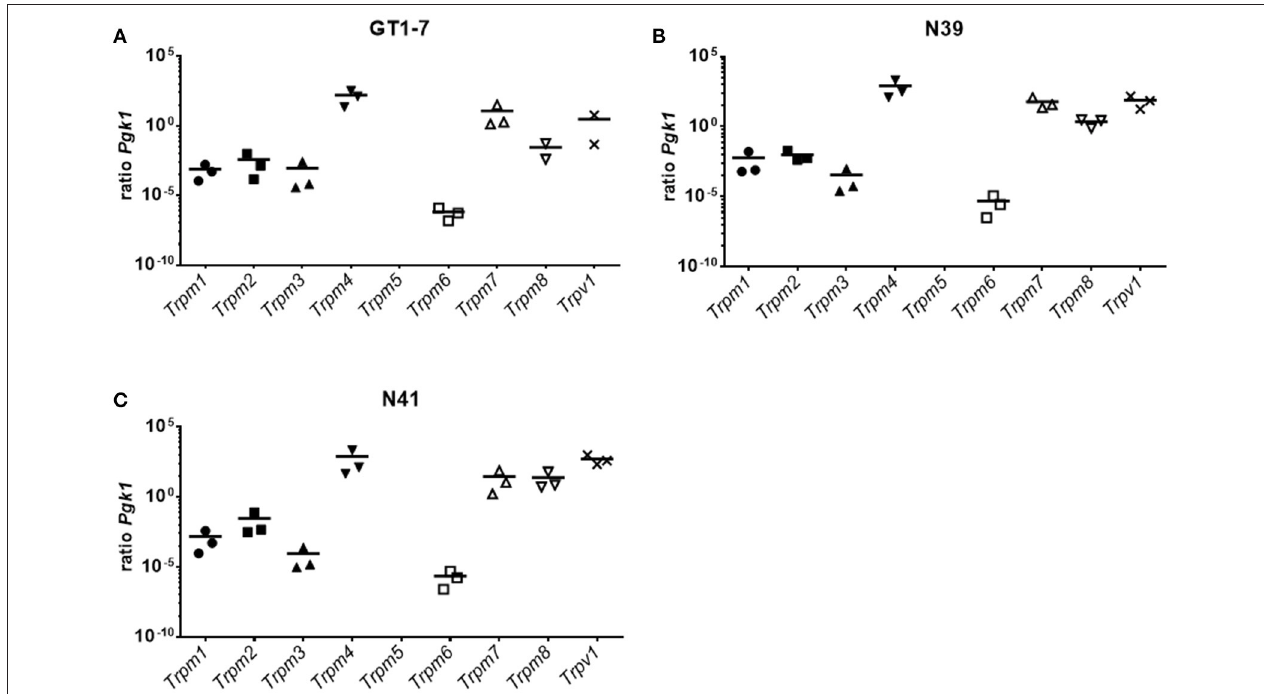
FIGURE 4 | Expression pattern of TRPM channels in (A) GT1-7, (B) N39 and (C) N41. Results of a SYBR Green based qPCR. Graphs show the ratio between the reference gene Pgk1 and the TRPM channels and the Trpv1 . The three hypothalamic cell lines show a resemblance of expression pattern. Trpm4 has always the highest expression. A cluster of Trpm7 , Trpm8, and Trpv1 display the second highest ratios compared to Pgk1 . Trpm1 , Trpm2, and Trpm3 also form a cluster with similar expressions, however clearly lower expressed than Trpm7 , Trpm8, and Trpv1 . Trpm6 is detected at with the least mRNA content of all TRPMs. Trpm5 is not expressed in these cell lines. Data was pooled from three independent experiments measured in duplicates.